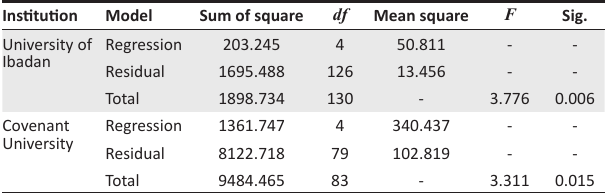
TABLE 2: F -statistic test.